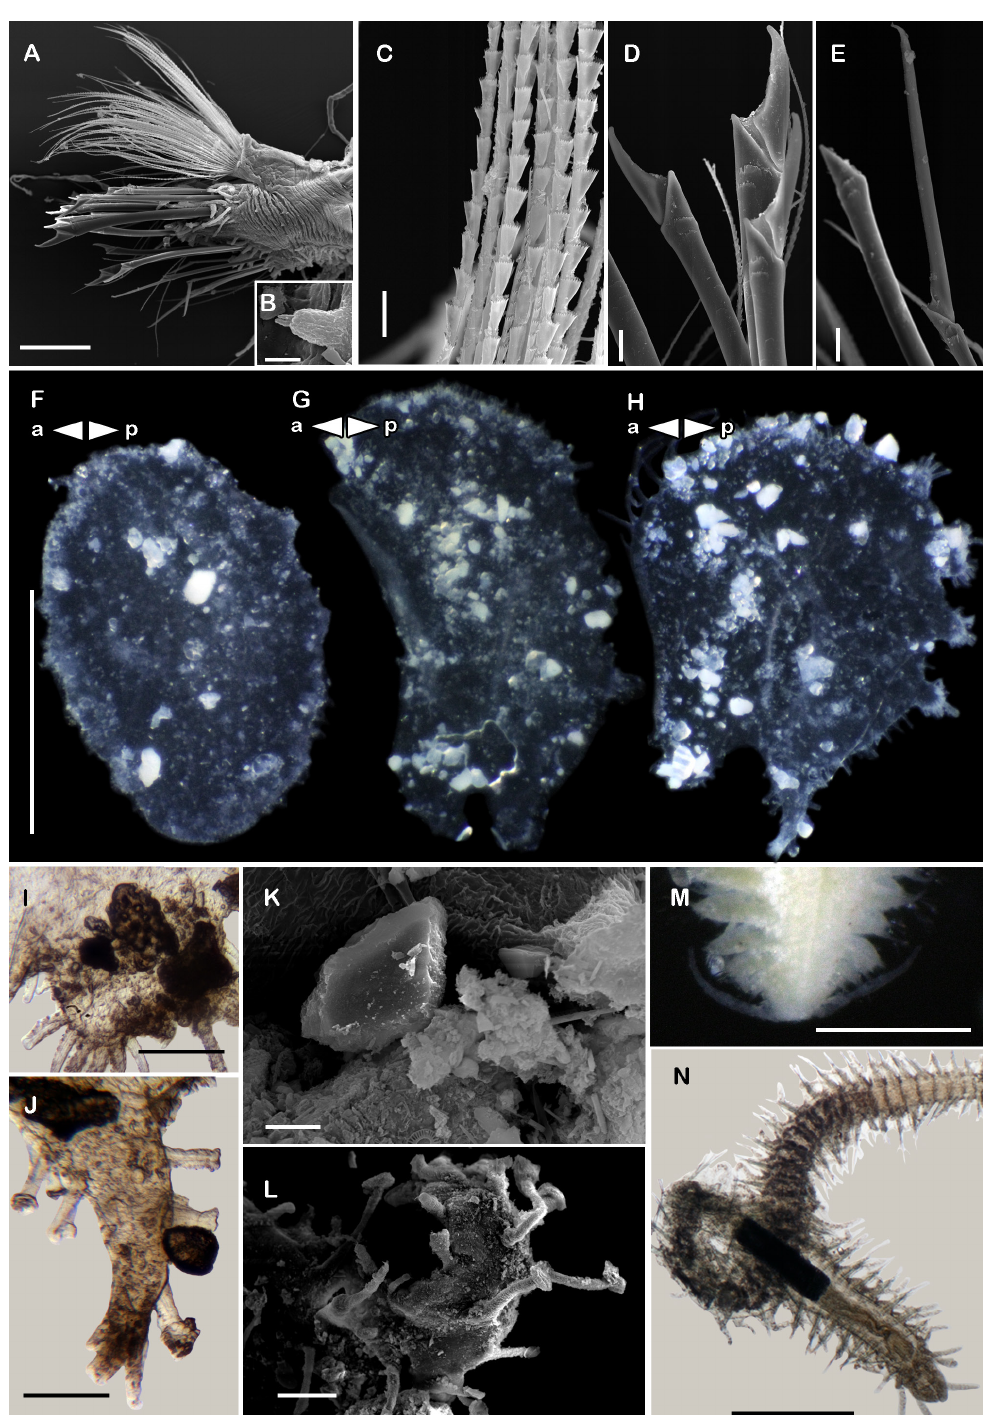
Fig. 22. Pelogenia salazarvallejoi sp. nov., holotype (UF 2757). A–E, K–L. SEM micrographs. A . Parapodium from segment 23. B . Neuropodial papilla with ‘thick cilia’. C . Notochaetae from A. D . Units A and B. E . Subunit 2. F . First left elytron. G . Second left elytron. H . Posterior right elytron. I . Medial process of G. J . Medial process of H. K . Flat papillae from posterior elytron. L . Medial process from posterior elytron. M . Pygidium. N . Syllid associated between posterior elytra. Abbreviations: a = anterior; p = posterior. Scale bars: A = 200 μm; B = 5 μm; C = 10 μm; D–E = 20 μm; F–H = 1 mm; I–L, N = 50 μm; M = 500